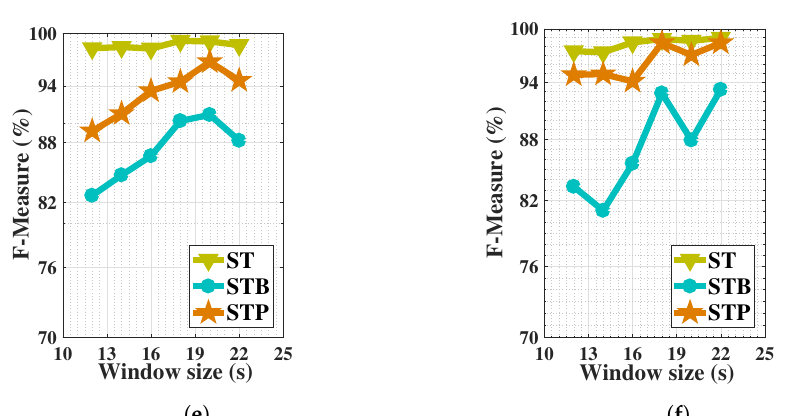
Figure 8. The impact of the long-size window on activities at: ( a ) the RH position using KNN; ( b ) the LH position using KNN; ( c ) the TP position using KNN; ( d ) RH using DT; ( e ) the LH position using DT; ( f ) TP using